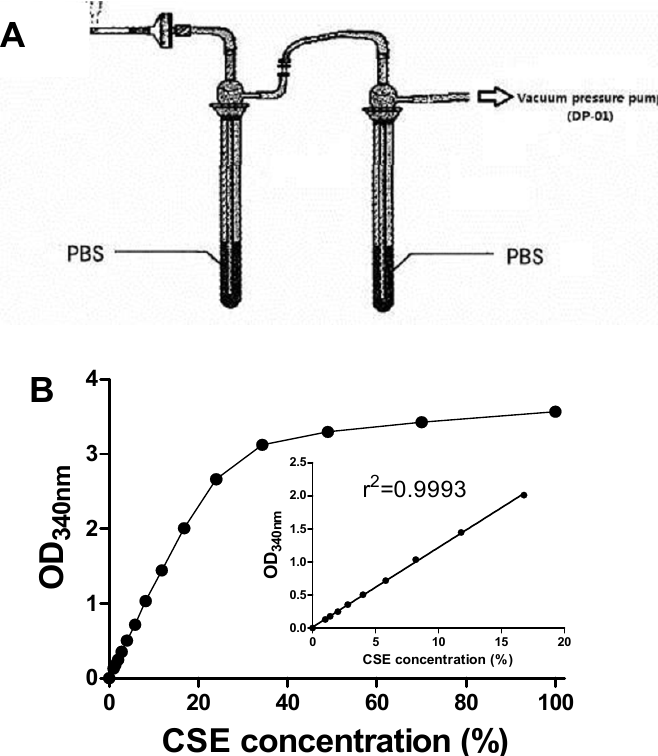
Figure 1. Device for preparing cigarette smoke extract (CSE) ( A ) and assessment of CSE concentration ( B ). Data are presented as means ± SEM ( n = 2).